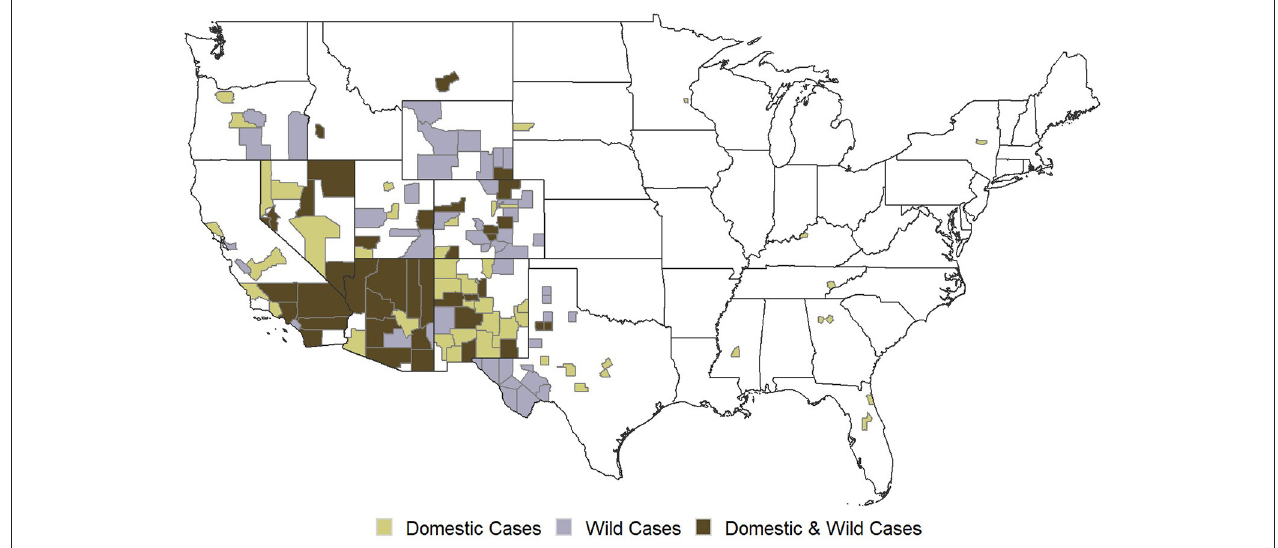
FIGURE 1 | Occurrence of RHDV2 in the United States as of February 2022. The first case of RHDV2 detection in domestic rabbits in the eastern United States occurred in Lake County, Florida on December 30, 2020. Data source: USDA Animal and Plant Health Inspection Service